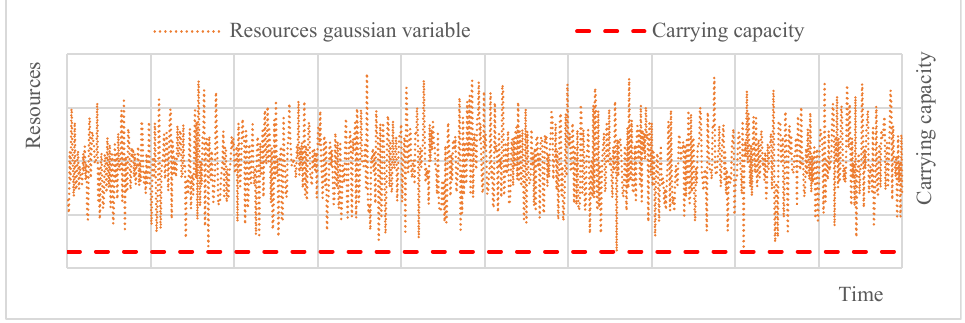
Figure 2. Toy model: the concept of environmental determinism. Outflows of the fountain follow a Gaussian distribution. Red dashed line shows the carrying capacity of the population.